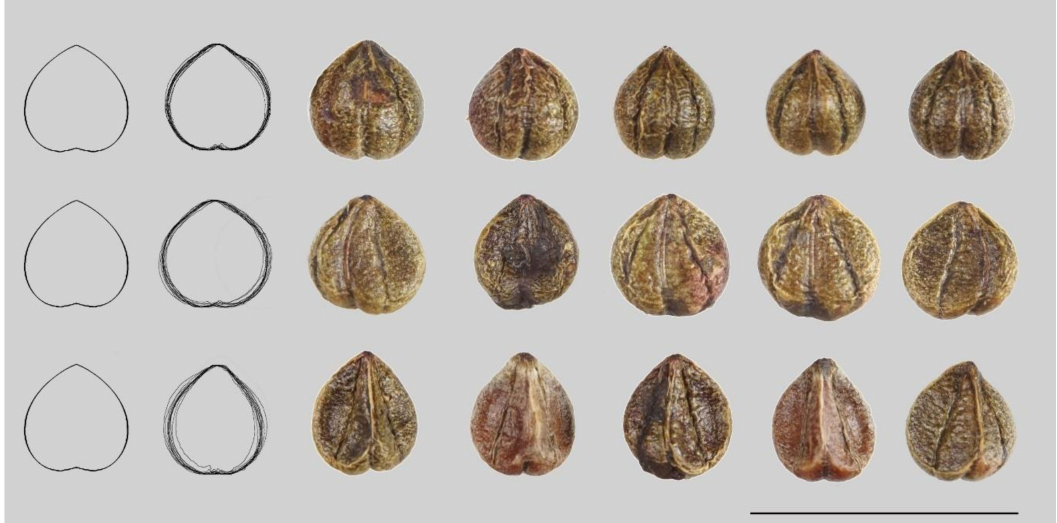
Figure 8. From left to right: Model 2 (three rounded heart curves), three figures composed with the silhouettes of 20 seed images, and five representative images of seeds of P. tricuspidata . The first row contains seeds from one-seed fruits; the second from two-seed fruits and the third, from three seed-fruits. The bar is equal to 1 cm.